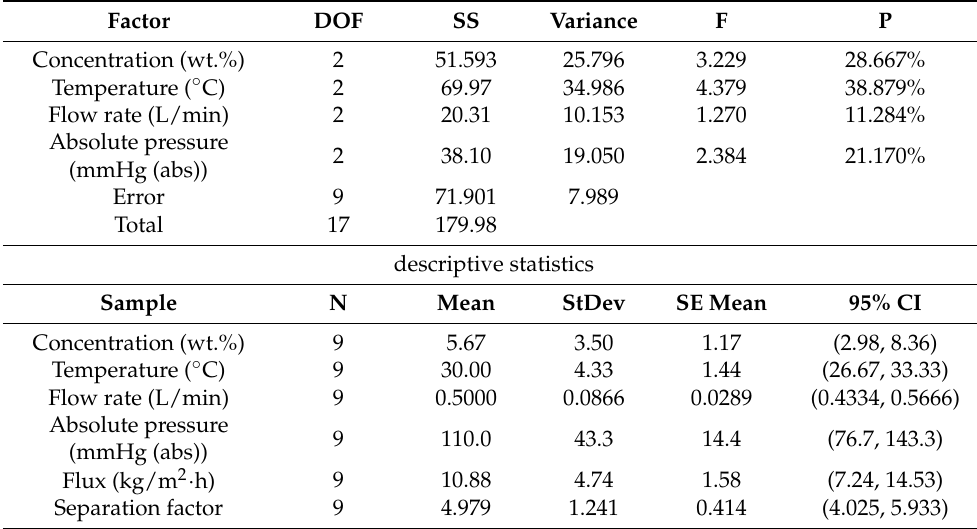
Table 5. Parameters of the statistical analysis and descriptive